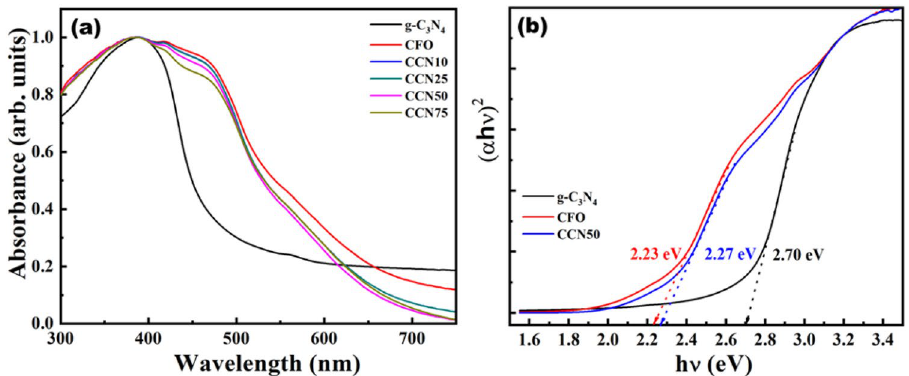
Figure 4. ( a ) UV–vis absorption spectroscopy of CFO, g-C 3 N 4 , CCN10, CCN25, CCN50 and CCN75 samples ( b ) Tauc plots corresponding to CFO, g-C 3 N 4 and CCN50.